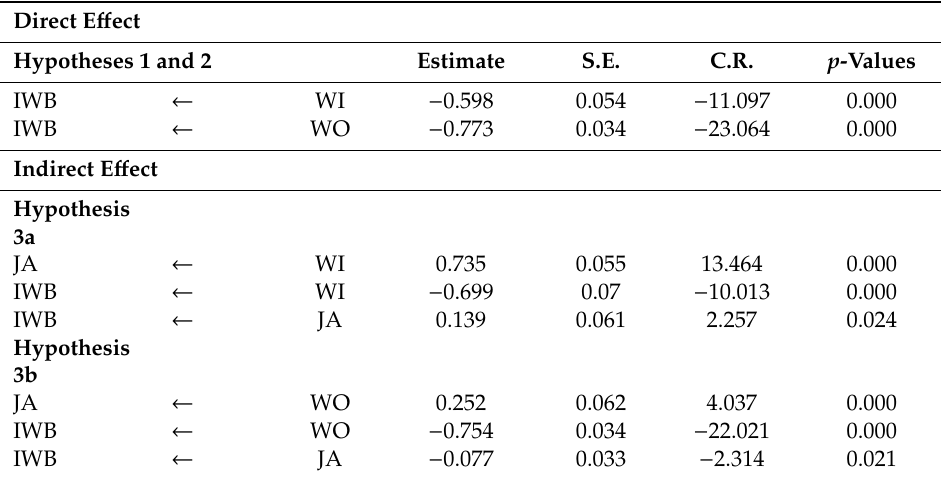
Table 4. Regression